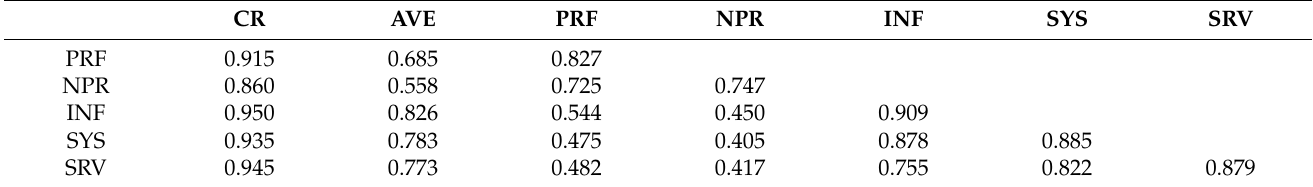
Table 3. Reliability and validity of the measurement